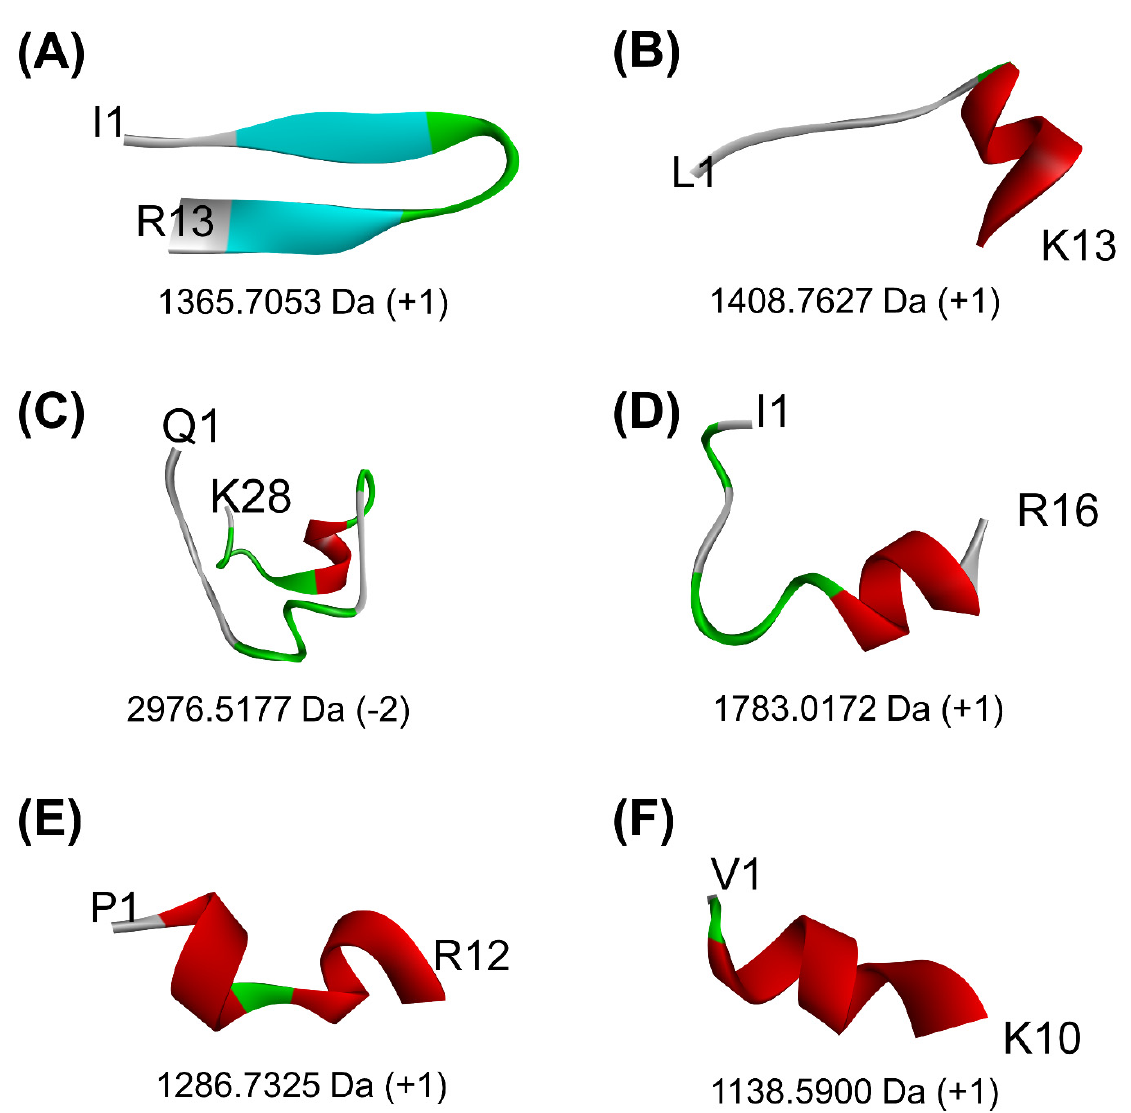
Figure 3. The 3D structures of six peptides predicted to bind to the key regions of both PirA vp and PirB vp that are involved in PirA vp /PirB vp complex formation: ( A ) ISYVVQGMGISGR, ( B ) LTFVVHGHALMGK, ( C ) QSLGVPPQLGNACNLDNLDVLQPTETIK, ( D ) ISTINSQTLPILSQLR, ( E ) PQFLVGASSILR, and ( F ) VQVVNHMGQK. The alpha-helical elements are shown in maroon, whereas the beta-strands are shown in light blue. Only the N- and C-terminal residues of each peptide are indicated. Values below each structure represent the molecular mass and the net charge of the peptide, as computed by PepDraw.